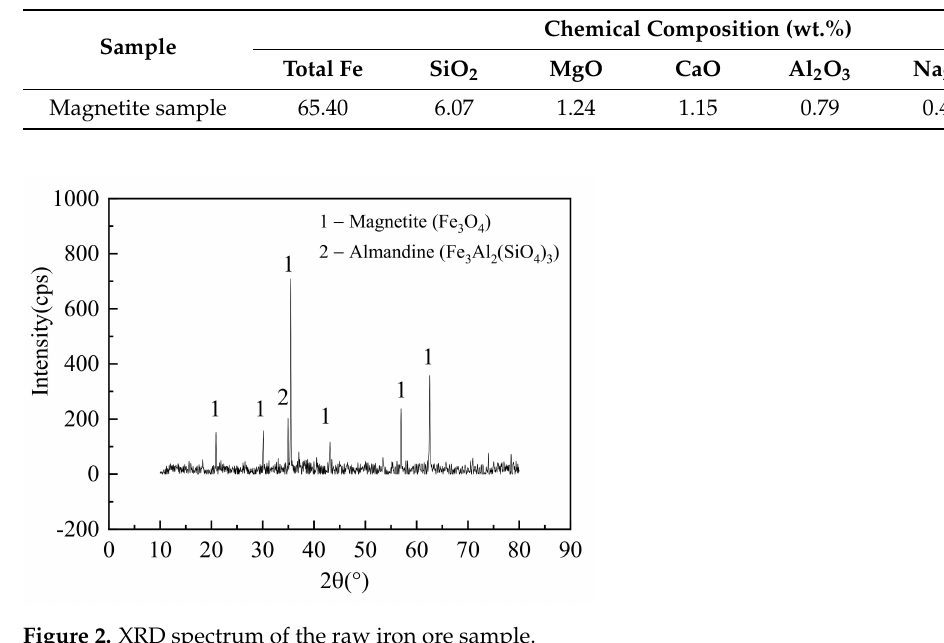
Table 1. Chemical composition of the raw iron ore sample.